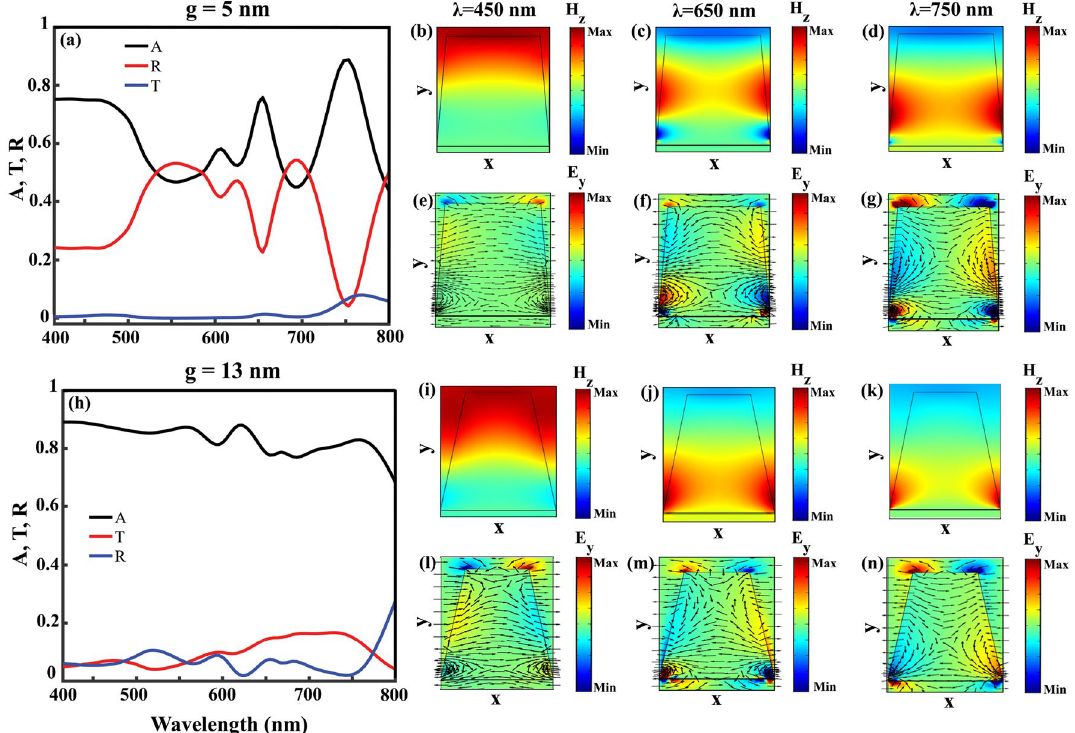
Figure 5. Reflection (R), transmission (T), and absorption (A) spectrum of the structure with p = w = 60 nm, ( a ) g = 5 nm and ( h ) g = 13 nm. At (cid:31) = 450 nm/ (cid:31) = 650 nm/ (cid:31) = 750 nm, ( b ) and ( i )/( c ) and ( j )/( d ) and ( k ) show the H z , and ( e ) and ( l )/( f ) and ( m )/( g ) and ( n ) illustrate the E y field distributions in the structure with g = 5 nm and g = 13 nm,